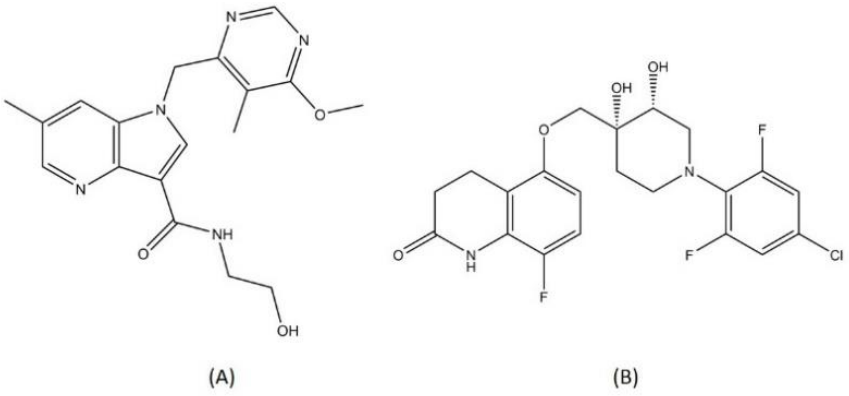
Figure 10. Structure of ( A ) TBI-7371 and ( B ) OPC-167832. Table 1. TB drugs in clinical trials [101].